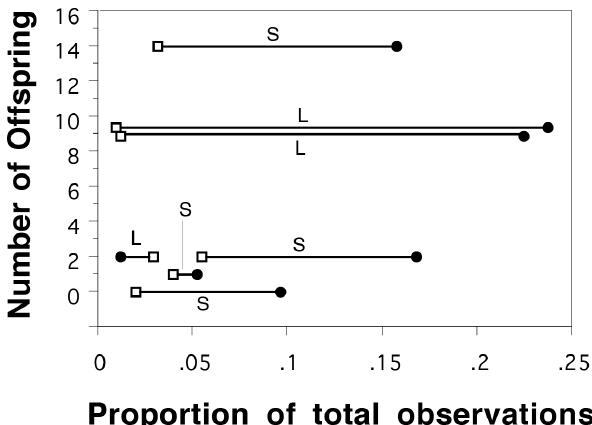
Figure 3. The proportion of behaviour related to aggressive interactions with other males (open squares) relative to active interactions with females (filled circles) for each male as a function of the number of offspring sired. Male body size is noted where ‘‘S’’ refers to small males (88–89 mm) and ‘‘L’’ refers to large males (95–96 mm). Males that spent a greater proportion of time interacting with females also tended to spend comparatively little time interacting with rival